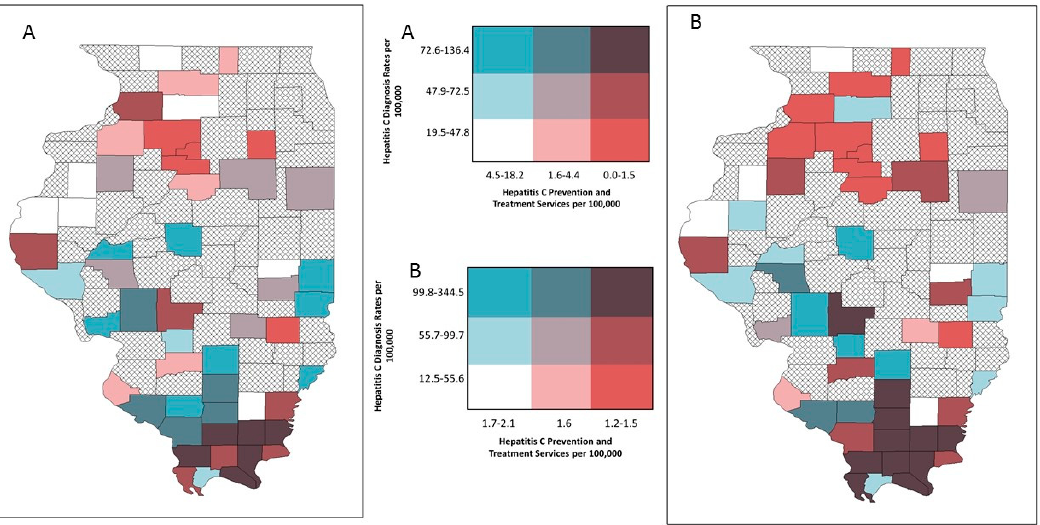
Figure 10. Bivariate choropleth maps of local health department services and disease burden, respondent rural counties, Illinois: hepatitis C prevention and treatment services and hepatitis C diagnosis rates; ( A ) crude rates ( B ) empirical Bayes estimated rates.